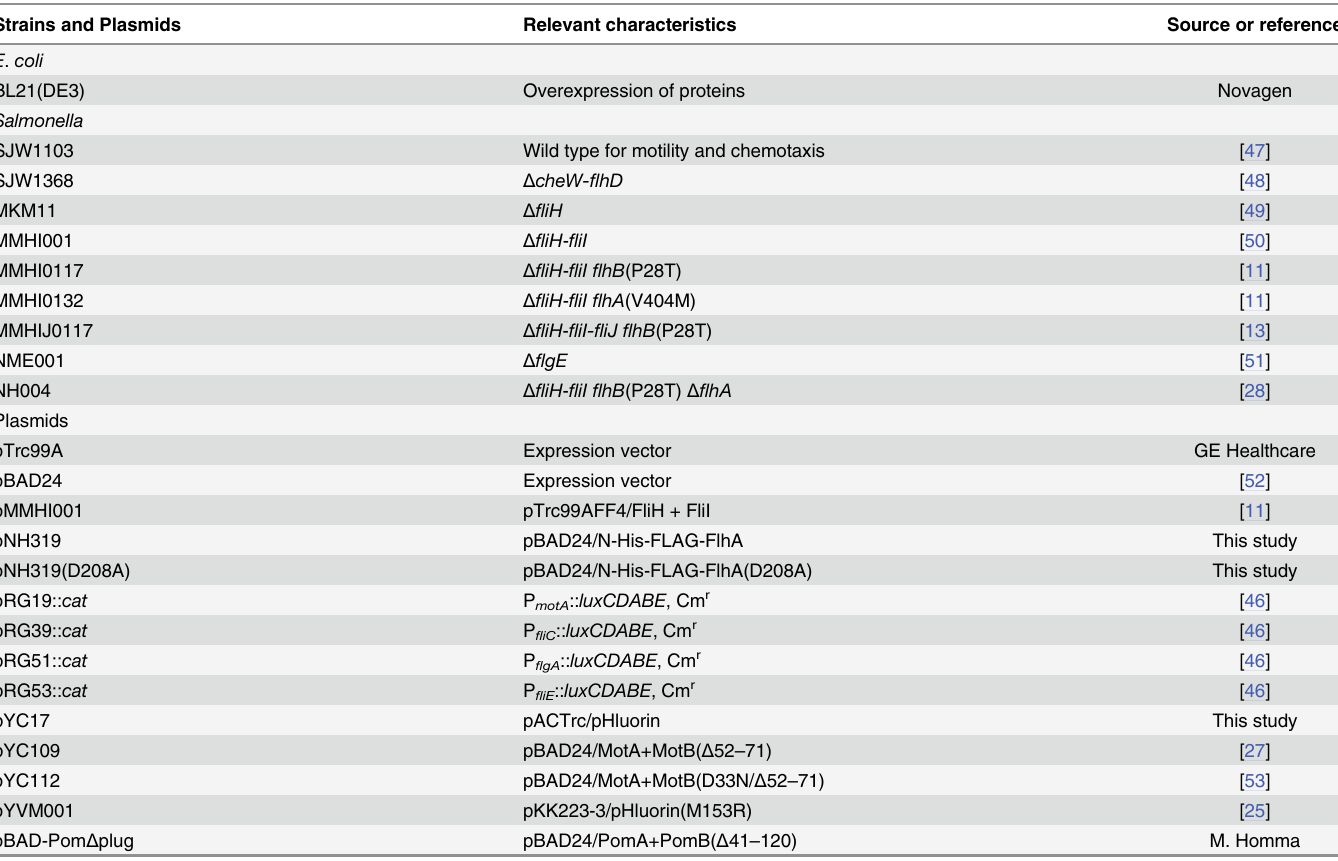
Table 1. Strains and plasmids used in this